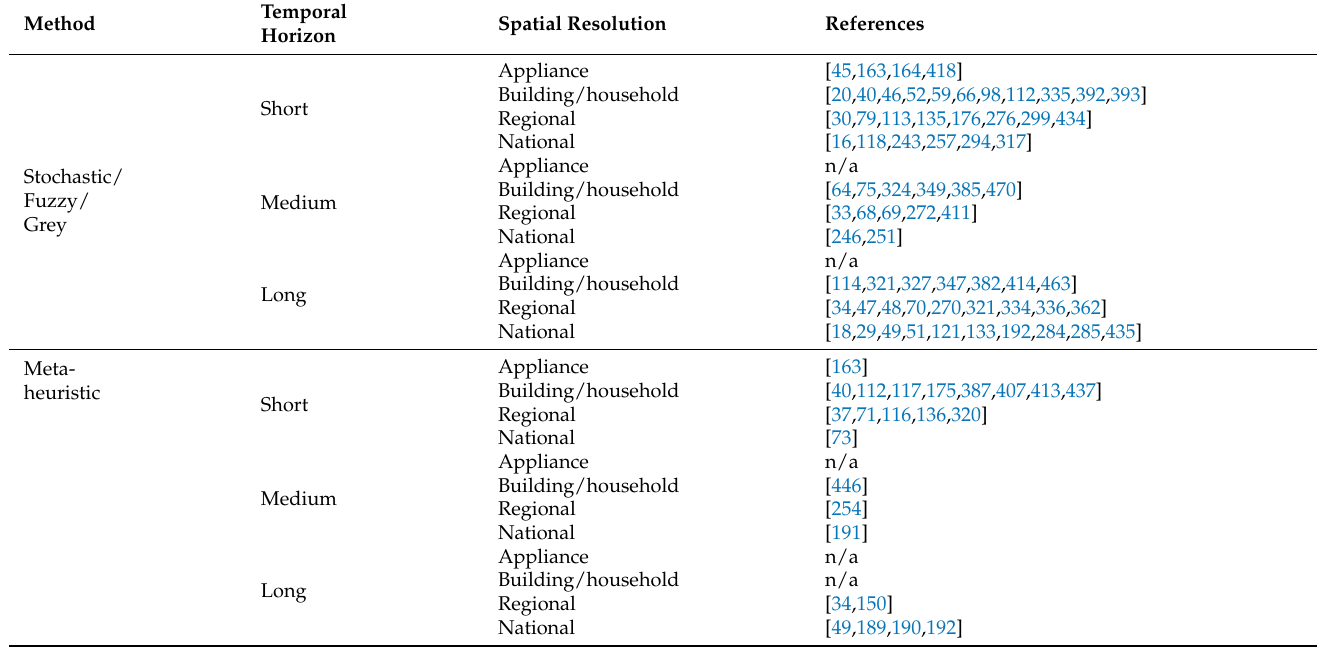
Table A9. Techniques and level of detail per article (2/2). Continuation of Table